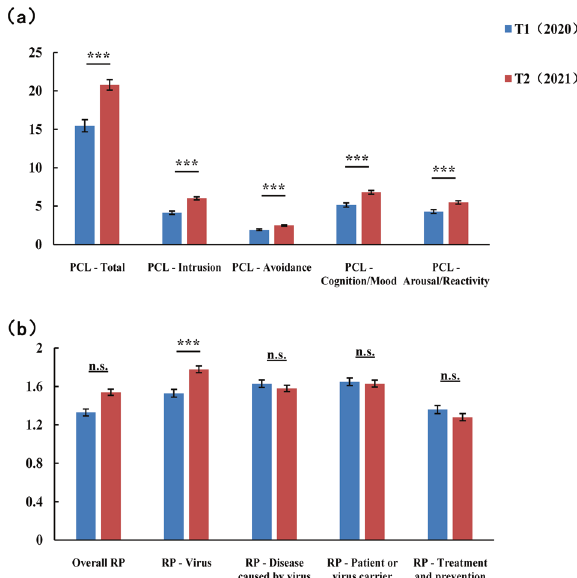
Fig. 2 Differences in the main study variables between T1 and T2. a Comparison of the total scores of the PCL-5 and its four subscales between T1 and T2. b Comparison of the overall risk perception towards the pandemic and its four hazards between T1 and T2. PCL Posttraumatic Stress Disorder Checklist for DSM-5, RP risk perception towards the pandemic, T1 the fi rst measurement point from May